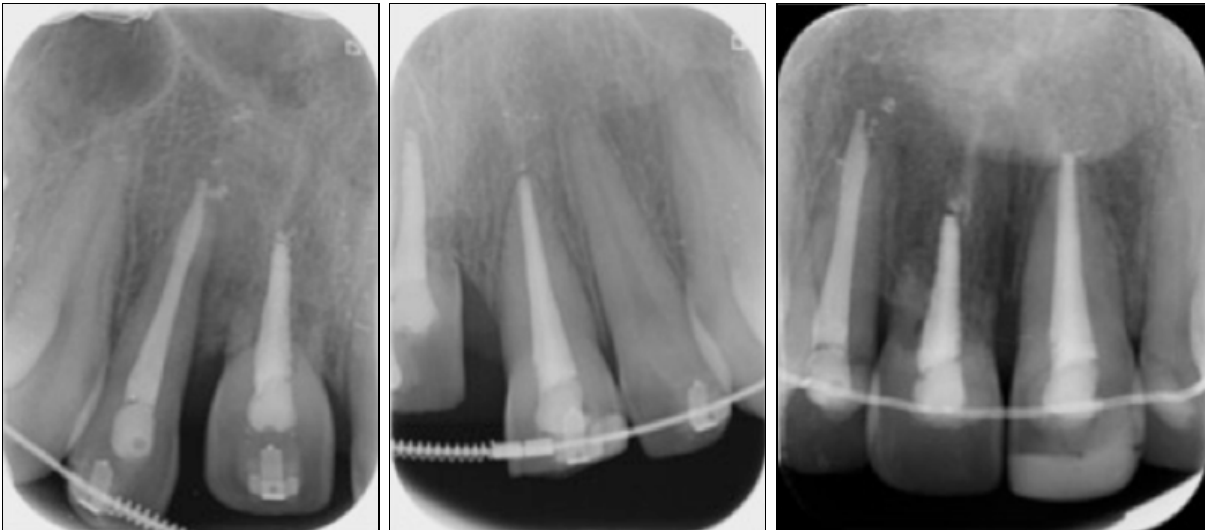
Figure 9. (from left to right): pre-surgical periapical radiograph of 12 &11; pre-surgical periapical radiograph of 21 and 11; and post-surgical/ post-treatment periapical radiograph of 12, 11 & 21.